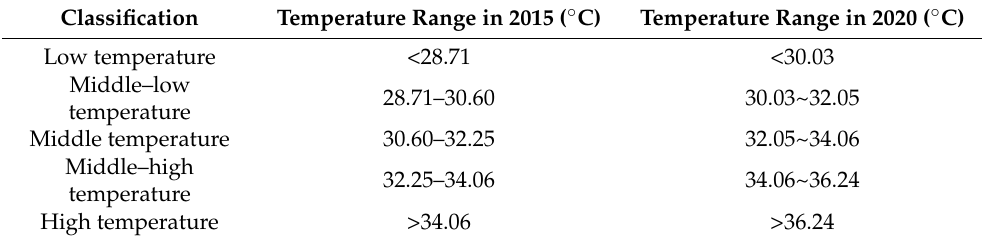
Figure 3. Land surface temperature derived from Landsat-8 OLI/TIRS images for the study area on 3 August 2015 ( a ) and 16 August 2020 ( b ), separately. Additionally, the temperature unit is centi- grade.